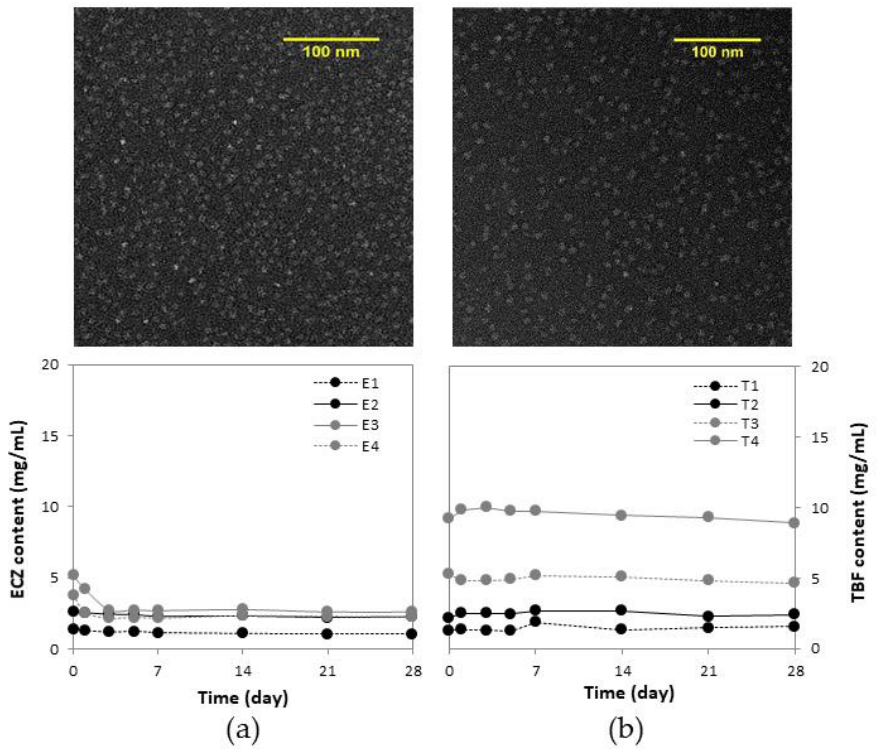
Figure 1. Characterization of ( a ) ECZ-loaded and ( b ) TBF-loaded micelles with respect to morphology using TEM (magnification 62,000×) and stability at 4 °C, over 4 weeks ( n = 3). To carry out comparisons with the marketed formulations, Pevaryl ® Cream (1% ECZ), Lamisil ® Cream (1% TBF), and Loceryl ® Cream (0.25% AMF), it was decided to prepare an antifungal “tri-therapy” formulation, but with 10-fold lower drug concentrations in the antifungal drug-loaded micelles.